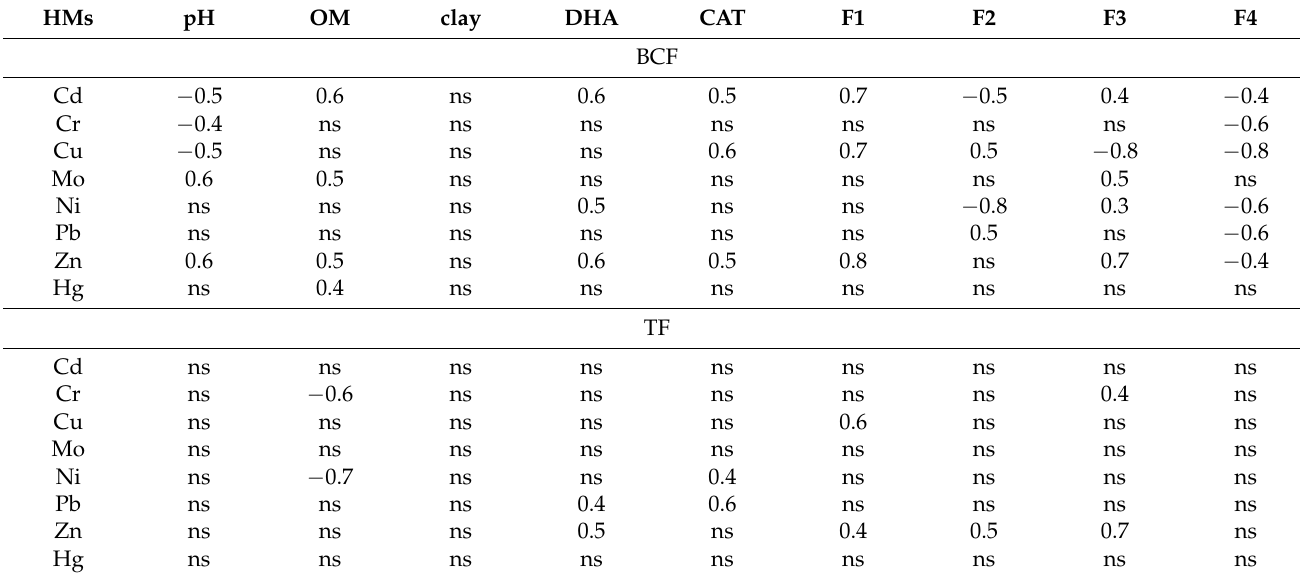
Table 3. This the Pearson’s correlation coefficients (r, p < 0.05) for BCF and TF of analyzed HMs and selected soil